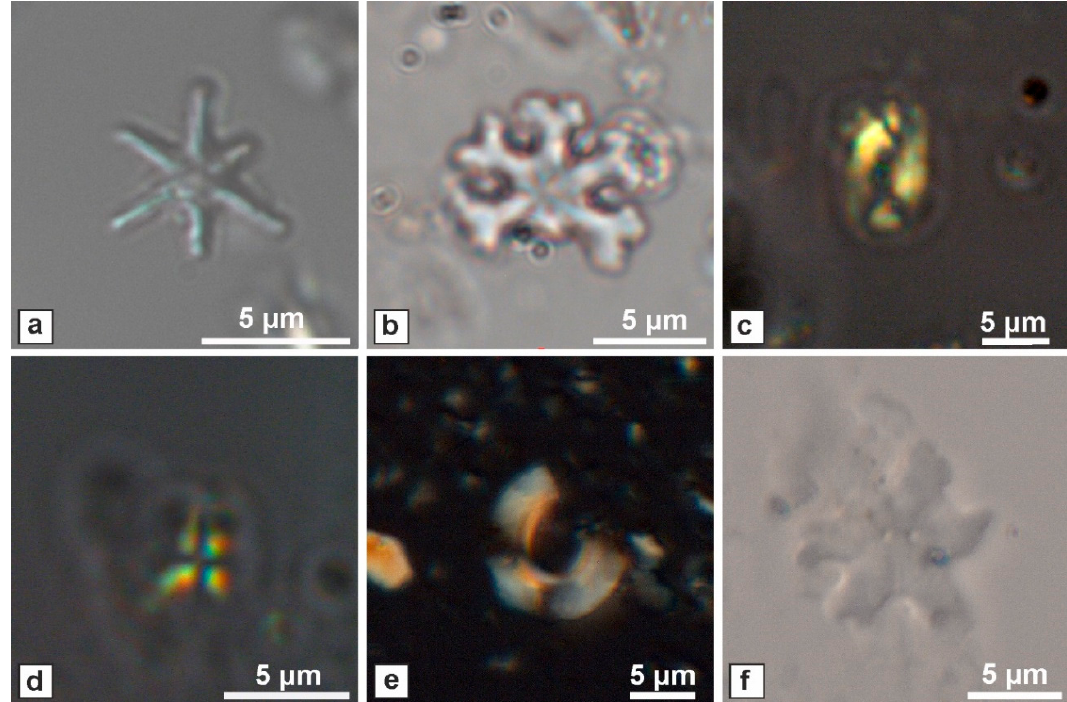
Figure 10. Microphotographs of the calcareous nannofossil species: ( a ) Discoaster brouweri , parallel nicols (sample CVTG 13); ( b ) Discoaster variabilis , parallel nicols (sample CVTG 13); ( c ) Helicosphaera wallichii , cross nicols (sample CVTG 9); ( d ) Sphenolithus abies , cross nicols (sample CVTG 3); ( e ) Rericulofenestra pseudoumbilicus , cross nicols (sample CVTG 4); ( f ) Discoaster loeblichii, parallel nicols (sample CVTG 18).